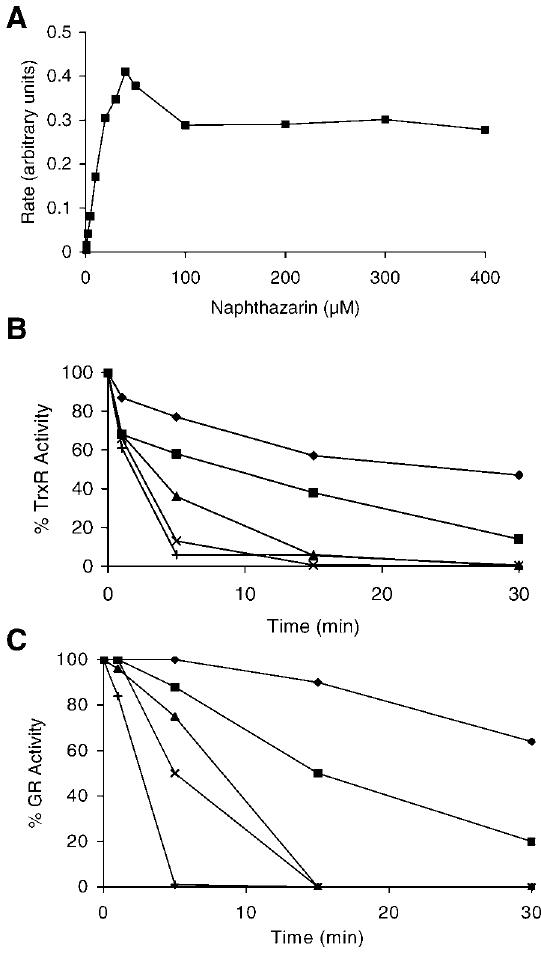
Figure 2. Naphthazarin Is a Substrate and Inhibitor of TGR (A) Activity of recombinant S. mansoni TGR with naphthazarin as a substrate was determined by NADPH consumption under steady-state conditions. (B) Time-dependent inhibition of TrxR activity of TGR by naphthazarin with DTNB as a substrate. Concentrations of naphthazarin are 0.5 l M ( ¤ ), 1 l M ( n ), 2.5 l M ( m ), 5 l M ( 3 ), and 10 l M ( þ ). (C) Time-dependent inhibition of TGR activity with GSSG. Concentrations of naphthazarin are 0.5 l M ( ¤ ), 1 l M ( n ), 2.5 l M ( m ), 5 l M ( 3 ), and 10 l M ( þ